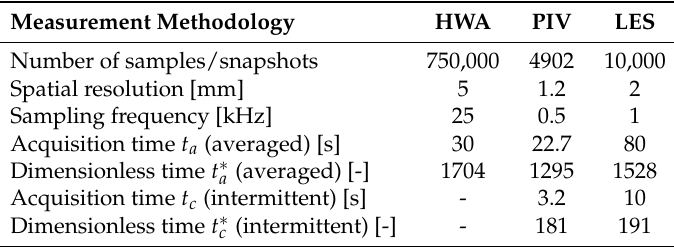
Table 1. Parameters of the methodologies HWA, PIV and